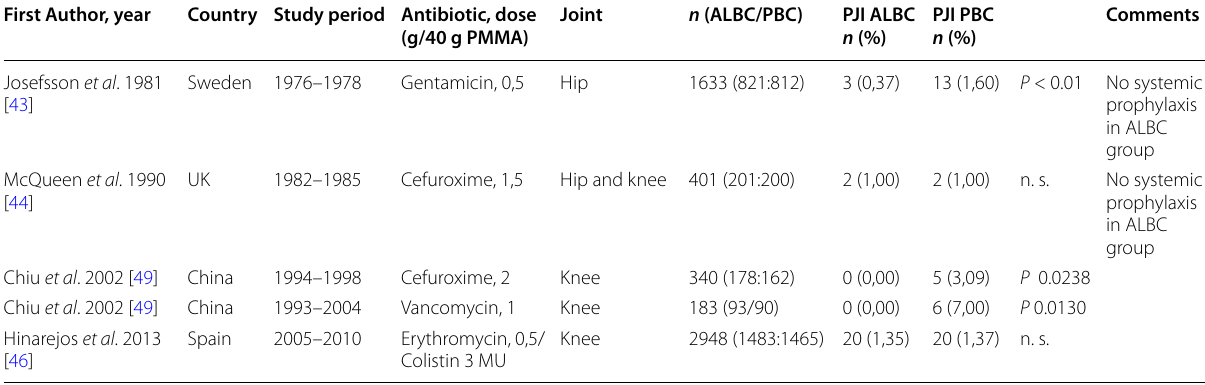
Table 1 Randomized controlled trials comparing ALBC vs . PBC in PJI prophylaxis during total joint